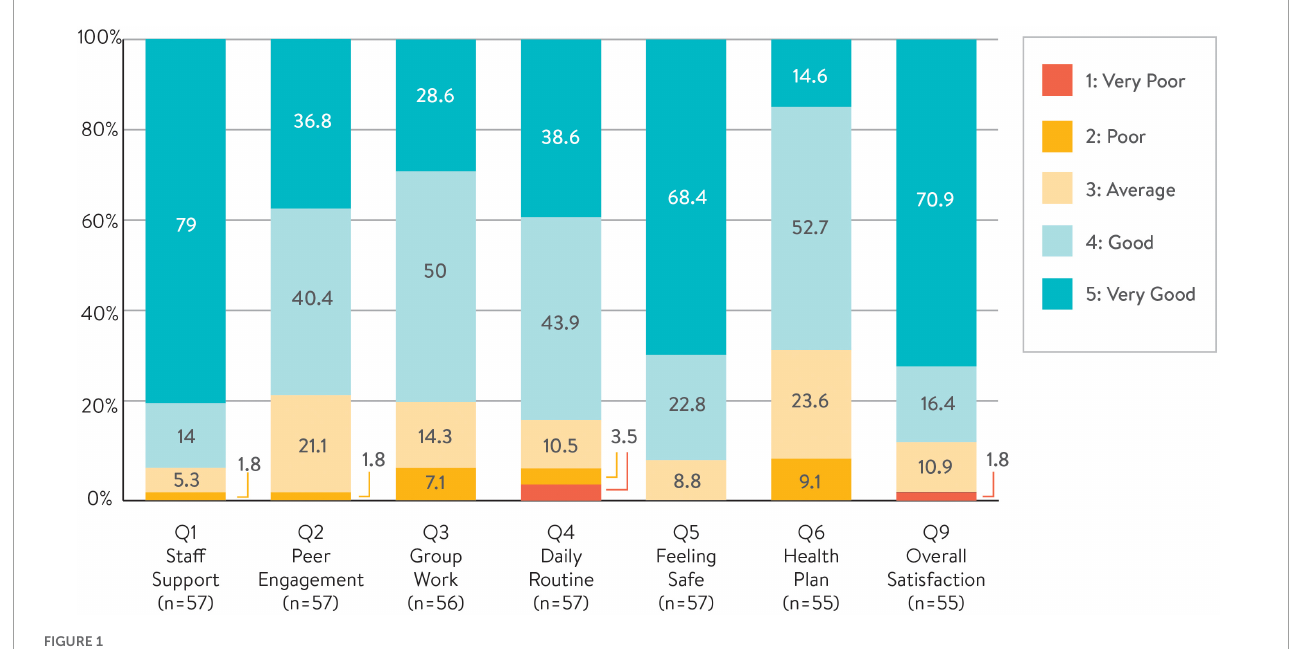
FIGURE1 Consumers’ satisfaction with service (sample sizes varies for each question).